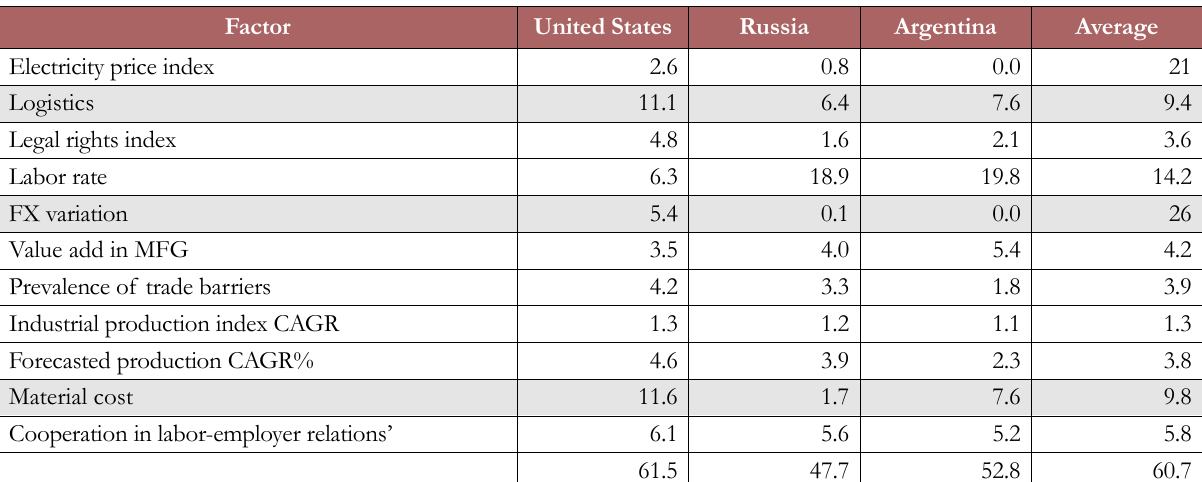
Table 8. United States, Russia, and Argentina compare